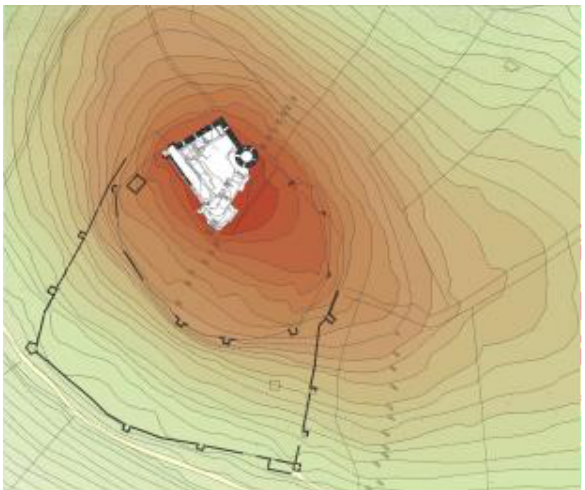
Figure 2: The map of the site (PIT,